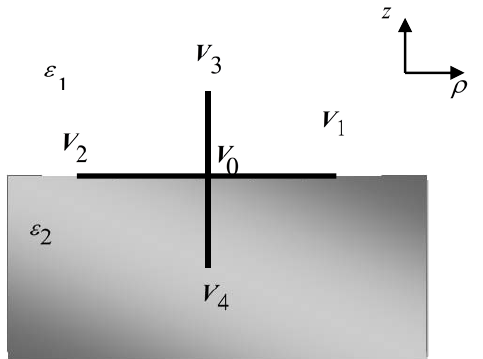
Figure 1. Interface between media of dielectric permittivity